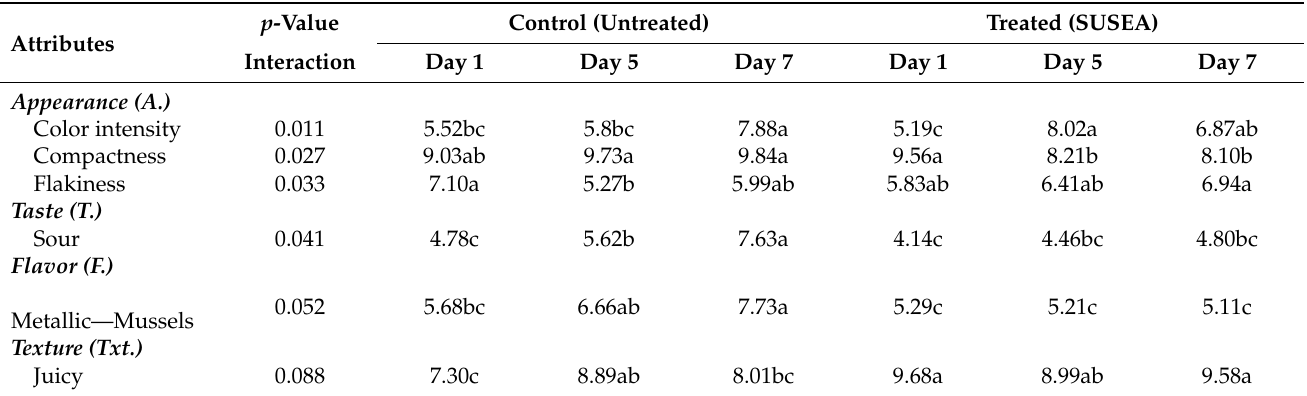
Table 6. Mean intensities (150 mm scale) of attributes showing a significant ( p < 0.05) interaction (Treatment*Day), according to the factorial 2-way ANOVA model (fixed factors: Treatment, Day and Interaction). Post hoc, Fischer LSD, lowercase letters indicate significant